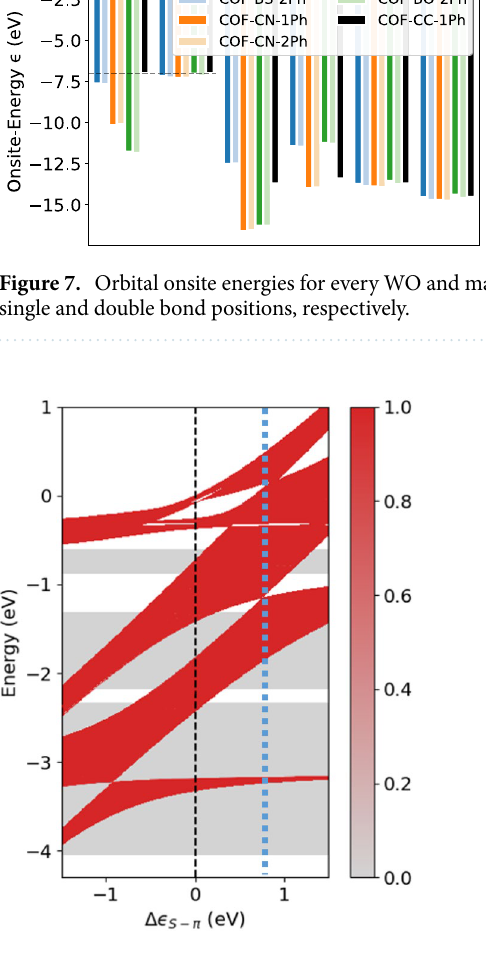
Figure 8. Impact of S- π onsite energy on the band structure of COF-BS-1Ph. Red color indicates high values of projection P π onto π -orbitals. The black dashed line shows the original onsite energy and the blue dashed line highlights the special case where all upper π -groups touch each other. The energy scale is set to zero at the highest occupied state of the original 2D COF for better